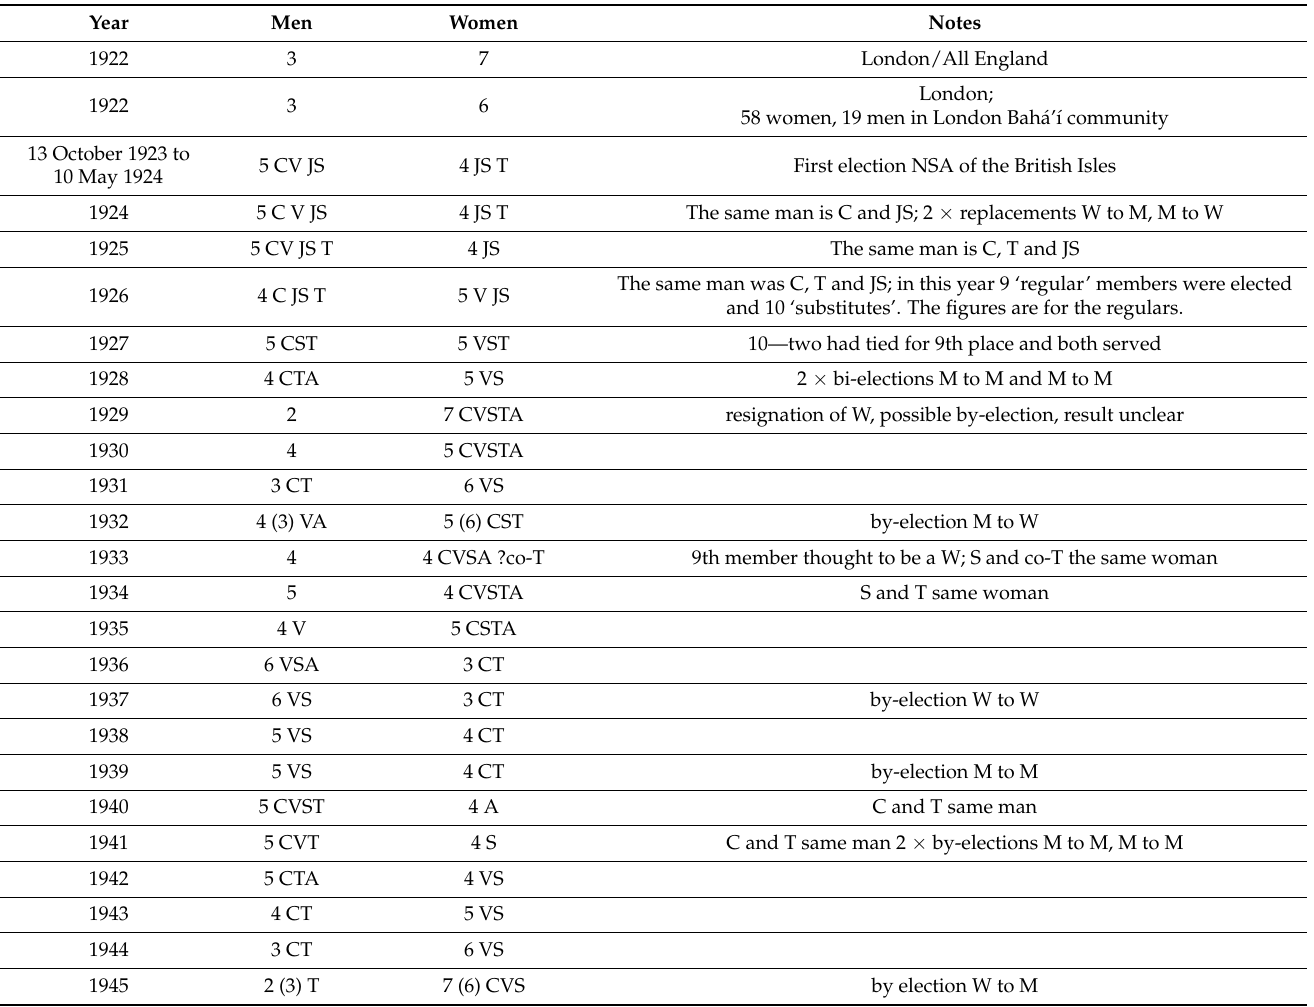
Table 1. Membership of the British National Spiritual